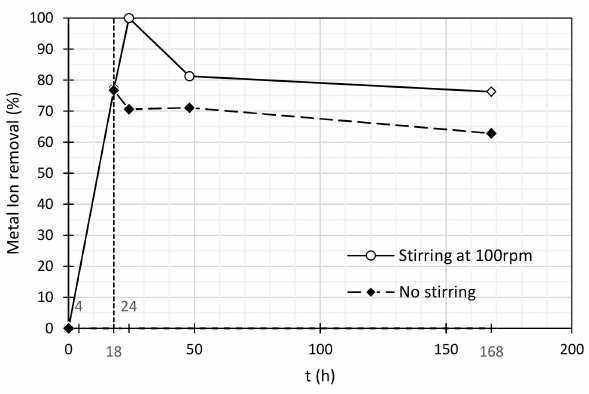
Figure 3. Ni (II) removal applying a suspension of 0.01% ( w / w ) of MWCNTs with 0.03% ( w / w ) of Pluronic F-127, with stirring at 100 rpm and no stirring. Initial concentration of Ni (II) ~3 mg/L.